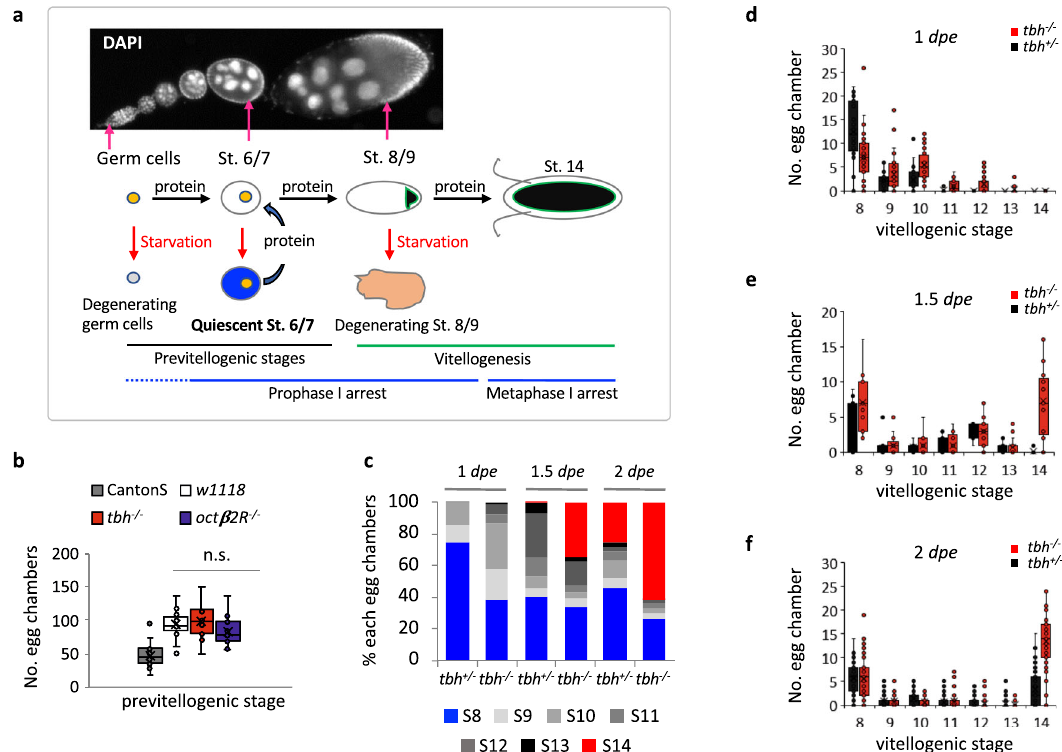
Fig. 5 Octopamine is required for maintaining previtellogenic egg chambers upon nutrient deprivation in D. melanogaster . a Oogenesis of D . melanogaster . Upon protein starvation, either germ cells or stage 8/9 egg chambers are degenerated. The previtellogenic egg chambers slow down the growth, then resume the growth within 2 h once protein is available. During egg chamber growth, meiotic chromosomes arrest at the prophase I until stage 13 (blue lines). b The number of previtellogenic egg chambers (stages 2 – 7) per fl y are similar between wild-type ( w 1118 ) female virgin controls ( n = 13 animals) and the octopamine mutant female virgins ( tbh − / − ( n = 11 animals) and oct β 2R − / − ( n = 14 animals)). Two-sided t -test: p = 0.63 ( w 1118 vs. tbh − / − ), 0.22 ( w 1118 vs. oct β 2R − / − ), 0.12 ( tbh − / − vs. oct β 2R − / − ). Canton-S ( n = 35) has fewer number of egg chambers than w 1118 . p = 5.5 × 10 − 11 (Canton-S vs. w 1118 ), 1.7 × 10 − 10 (Canton-S vs. tbh − / − ), 1.8 × 10 − 8 (Canton-S vs. oct β 2R − / − ). n.s.: not signi fi cant. c The percent of each stage of egg chambers in the ovaries of tbh + / − and tbh − / − virgins during the protein starvation period. The percent of stage 14 egg chambers increases in tbh − / − mutants compared to that of the heterozygote control, tbh + / − . These data are extracted from the raw data shown in d – f . d – f The distribution of each stage egg chambers in the ovaries of each tbh + / − ( n = 29 animals for 1 dpe , 14 animals for 1.5 dpe , 59 animals for 2 dpe ) and tbh − / − ( n = 32 animals for 1 dpe ; 17 animals for 1.5 dpe , 59 animals for 2 dpe ) female virgin during the protein starvation period. At each time point, tbh − / − mutants contain more progressed egg chambers compared to tbh + / − . b , d – f Boxplots show the median, mean (X), interquartile range (IQR). The upper whisker: the maxima smaller than 1.5 times IQR plus the third quartile, the lower whisker: the minima larger than 1.5 times IQR minus the fi rst quartile. Source data are provided as a Source Data fi